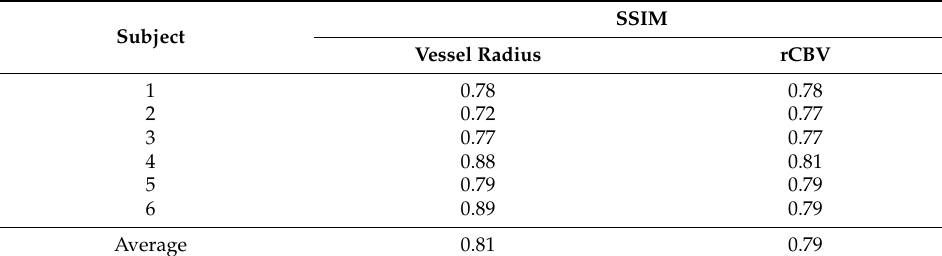
Table 2. Structural Similarity Index Measure (SSIM) between MR vascular fingerprinting (MRVF) and vessel size imaging (VSI) techniques in the estimation of vessel radius and rCBV maps for each subject.